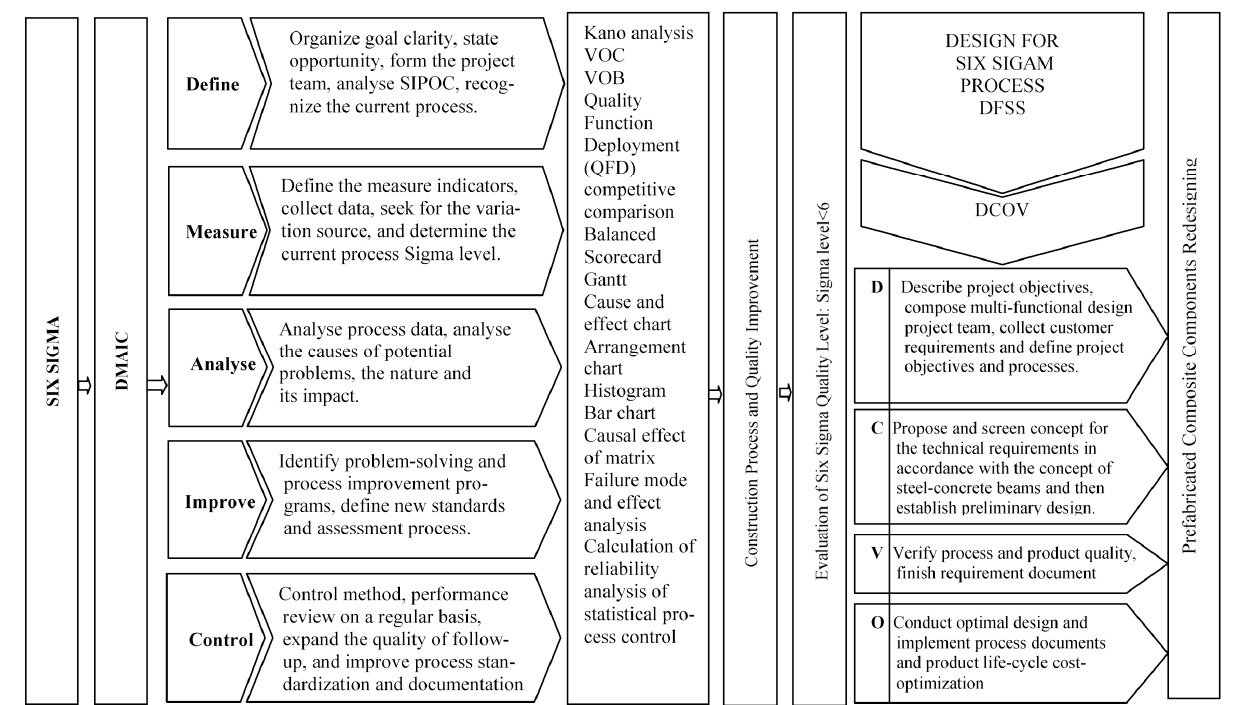
Fig. 1. Construction industry process management